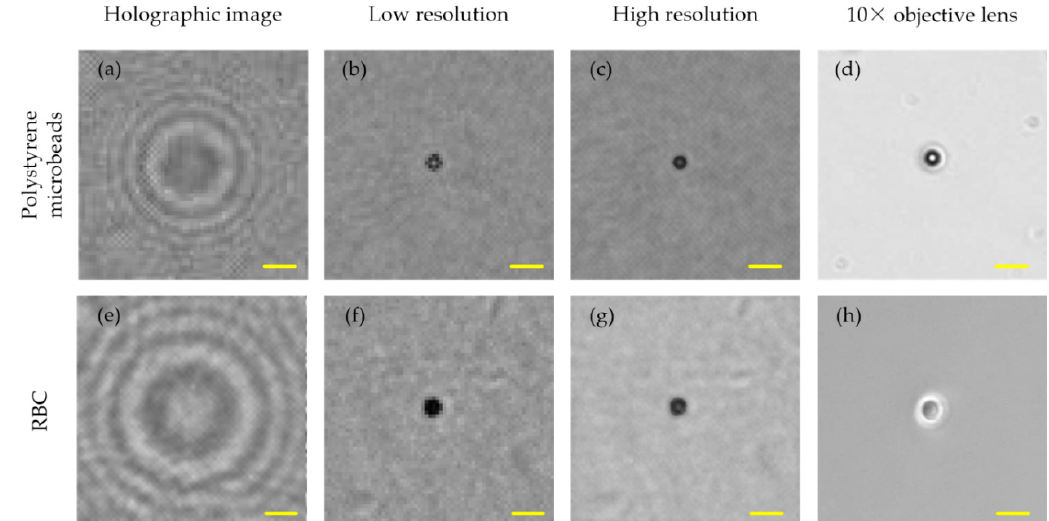
Figure 3. The super-resolution results. ( a , e ) A raw holographic image of polystyrene microbead (5 μ m in diameter) and red blood cell (RBC). ( b , f ) A low resolution image on the focus plane. ( c , g ) The high-resolution image on the focus plane. ( d , h ) A micrographic image using a 10× objective lens. The scale bar is 10 μ m.